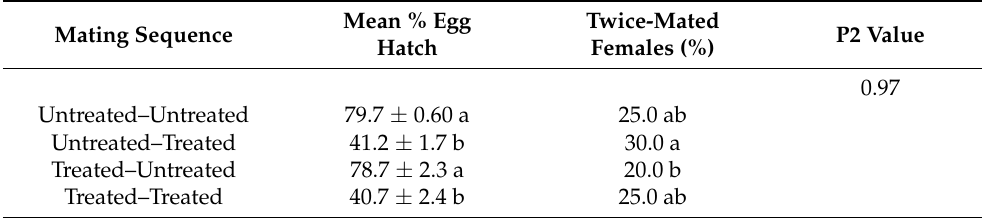
Table 4. Mean percentage of egg hatch ( ± SD) and percentage of twice-mated females in Lobesia botrana females mated sequentially with 150 Gy-treated and untreated males. Mean % Egg Twice-Mated P2 Value Mating Sequence Hatch Females (%) 0.97 Untreated–Untreated 79.7 ± 0.60